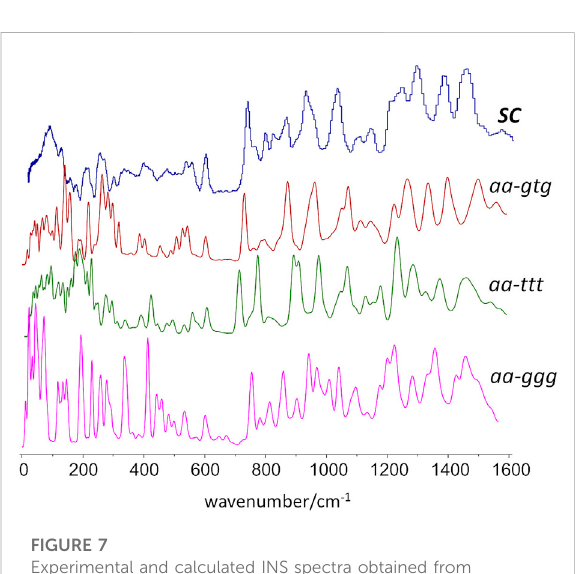
FIGURE 7 Experimental and calculated INS spectra obtained from periodic DFT calculations based on different conformational arrangements of the butylene skeleton. From top to bottom, experimental spectrum, calculated spectra for crystalline models with gtg , ttt , and ggg